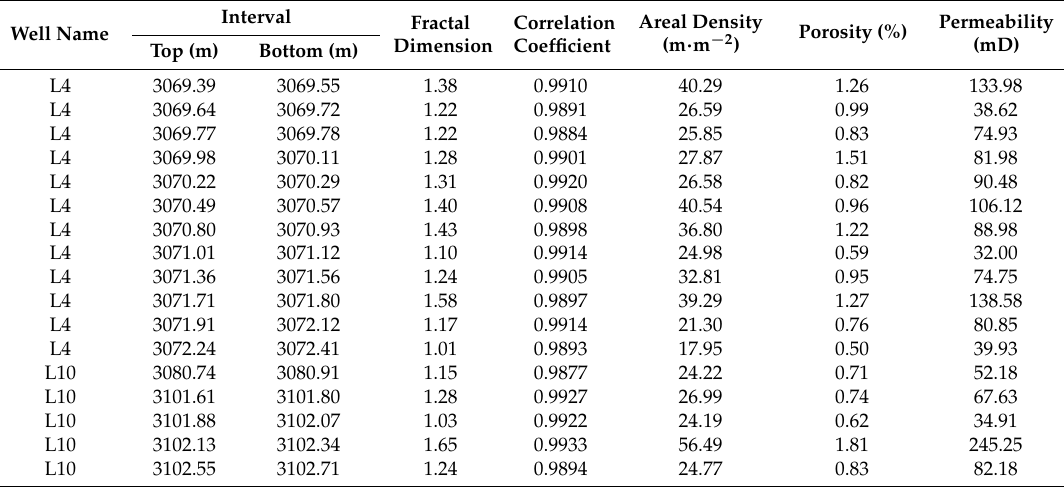
Table 1. Fracture parameters (fractal dimension, areal density, porosity and permeability) calculated from cores.